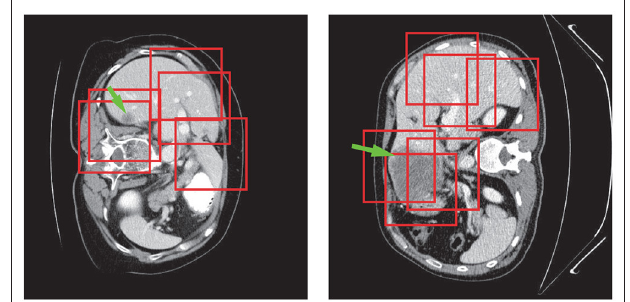
FIGURE 6 | Tumor patch extraction results. The green arrows point to the tumor regions and the red boxes show the patches used for training.